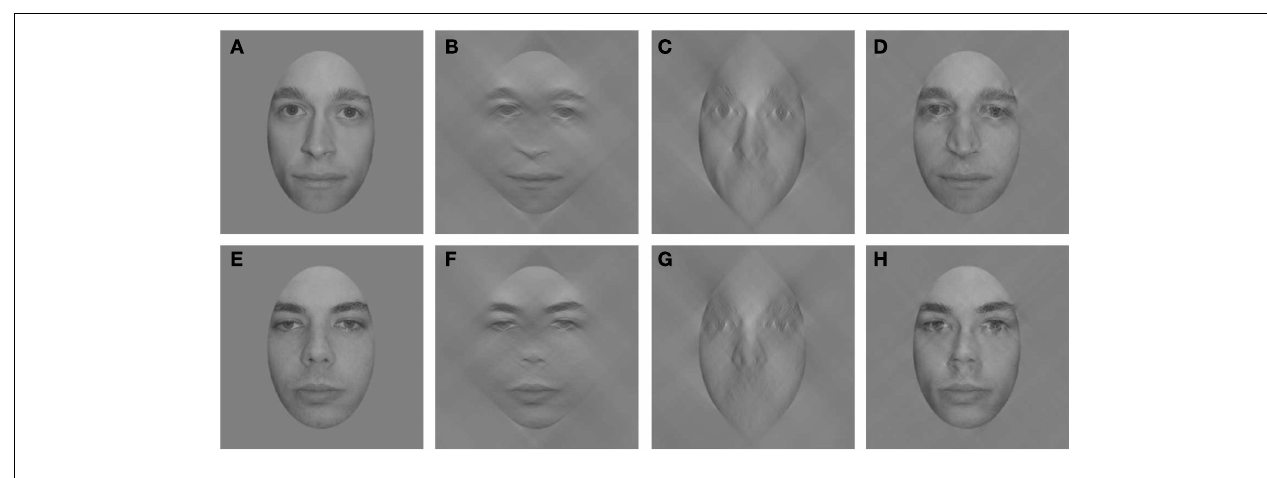
information from the other resemble the face from which the horizontal information is drawn (D = B + G and H = F + C). Note that equating the RMS contrast of the filtered components has a negligible effect on the